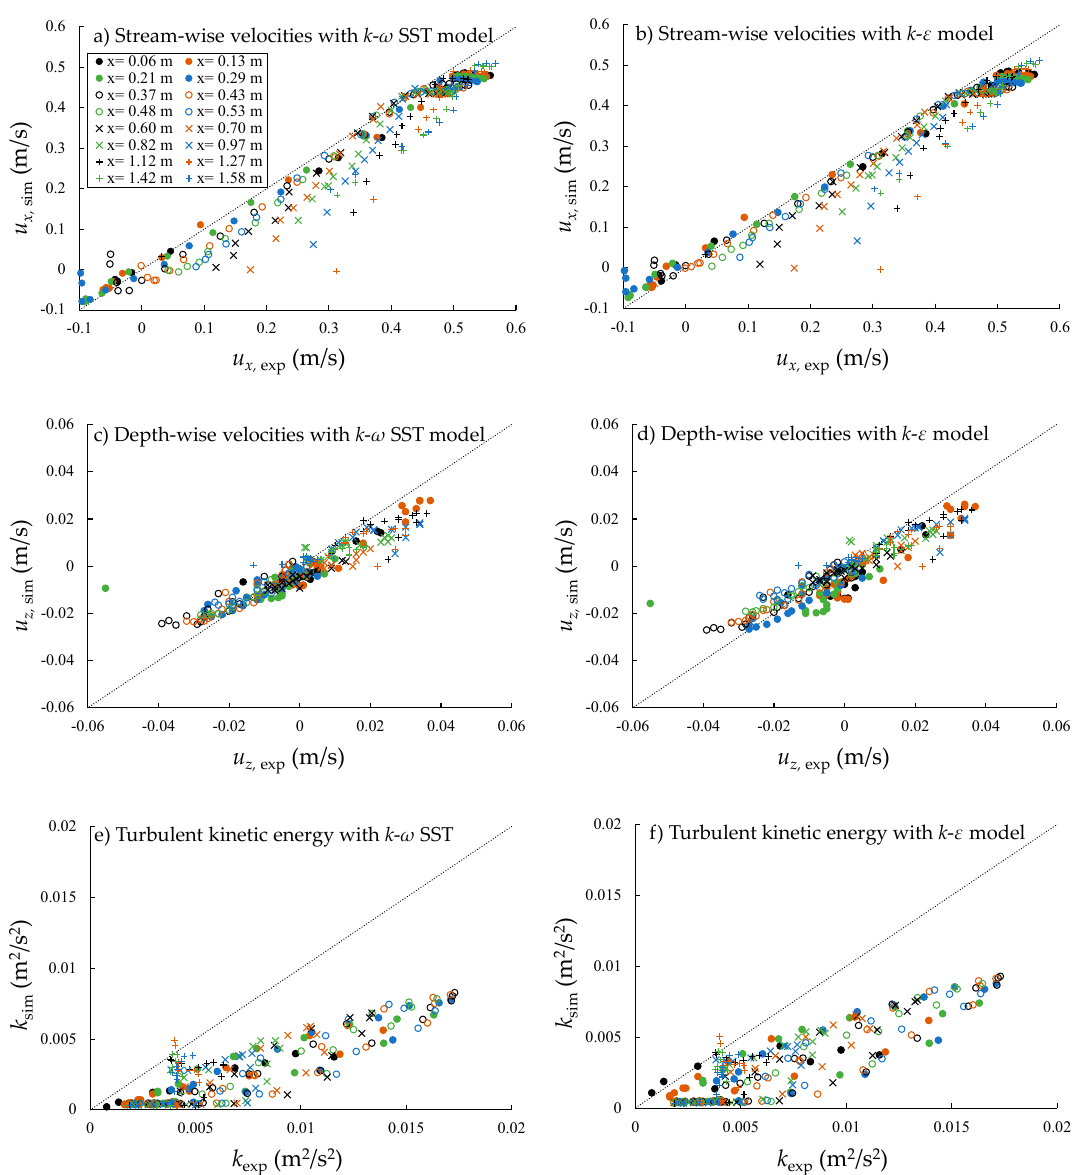
Figure 9. Comparison of simulated and experimental data of flow velocity and TKE with perfect line of agreement ( = dashed line) of Case 3 ( k s = 3 D 90 ).